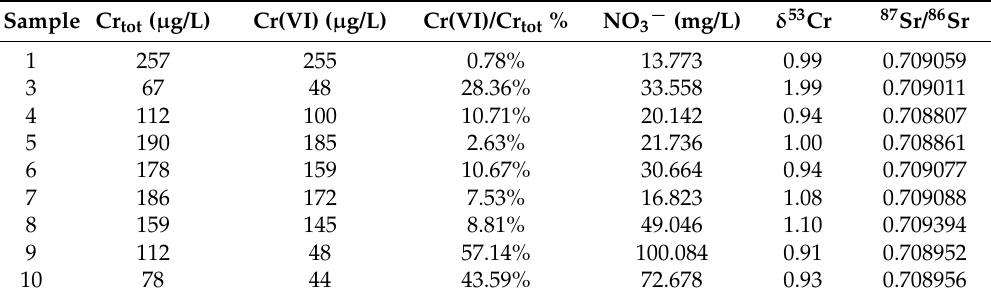
Figure 8. NO 3 vs. 87 Sr/ 86 Sr ratios, plot. Table 2. Cr (tot) and Cr (VI) concentrations and isotopic determination.